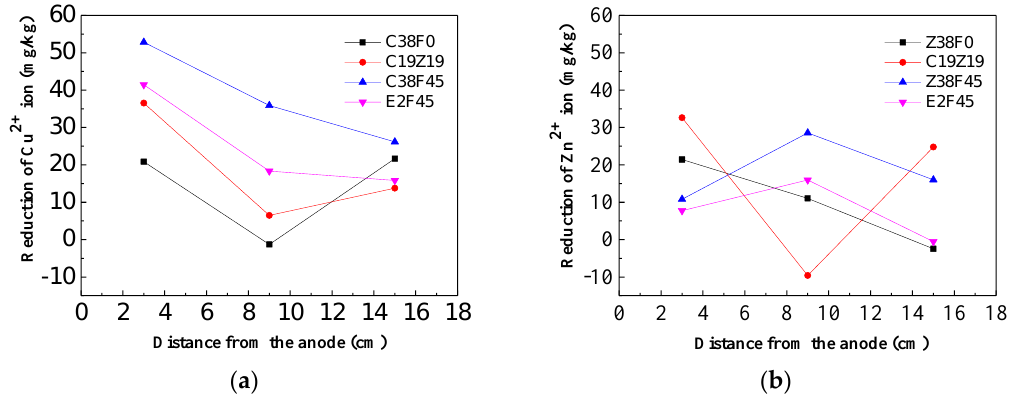
Figure 8. Reduction of Cu 2+ and Zn 2+ ion in sediment. ( a ) Reduction of Cu 2+ ion; ( b ) Reduction of Zn 2+ ion.